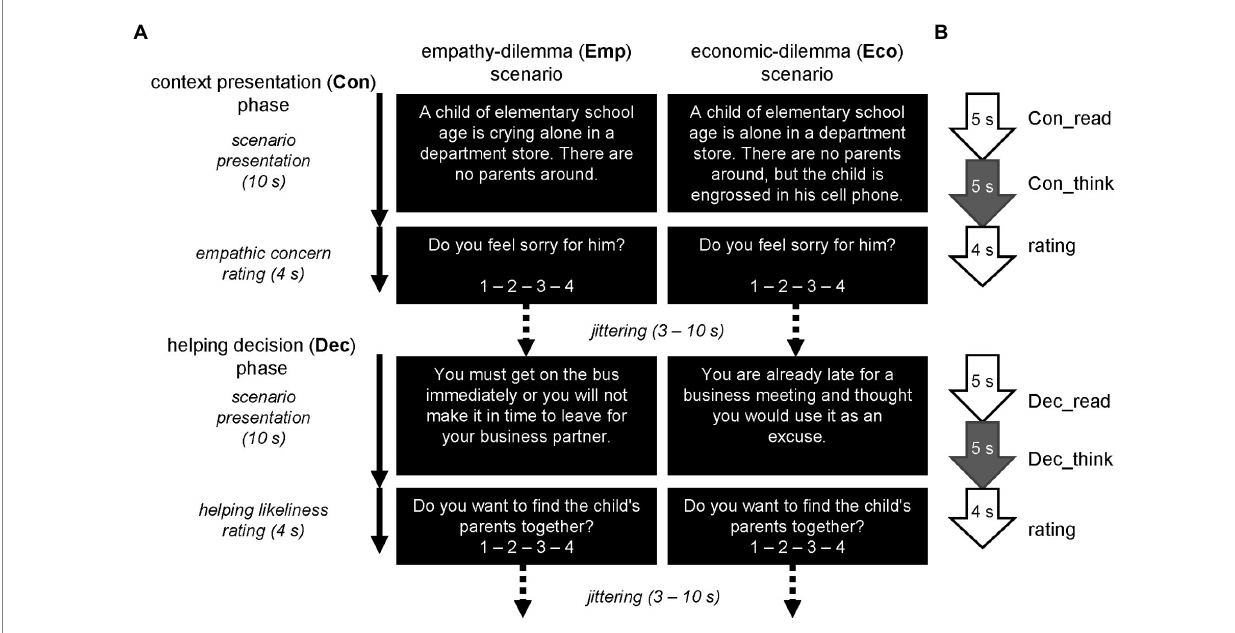
FIGURE 1 (A) : Experimental design. A pair of empathy-dilemma (Emp) and economic-dilemma (Eco) scenarios is shown as an example. (B) : Process model for fMRI analysis. Scenario presentation period was split in the middle and neural process in its latter half (thinking period) was compared between scenario types (i.e., Emp vs. Eco) separately for Con and Dec